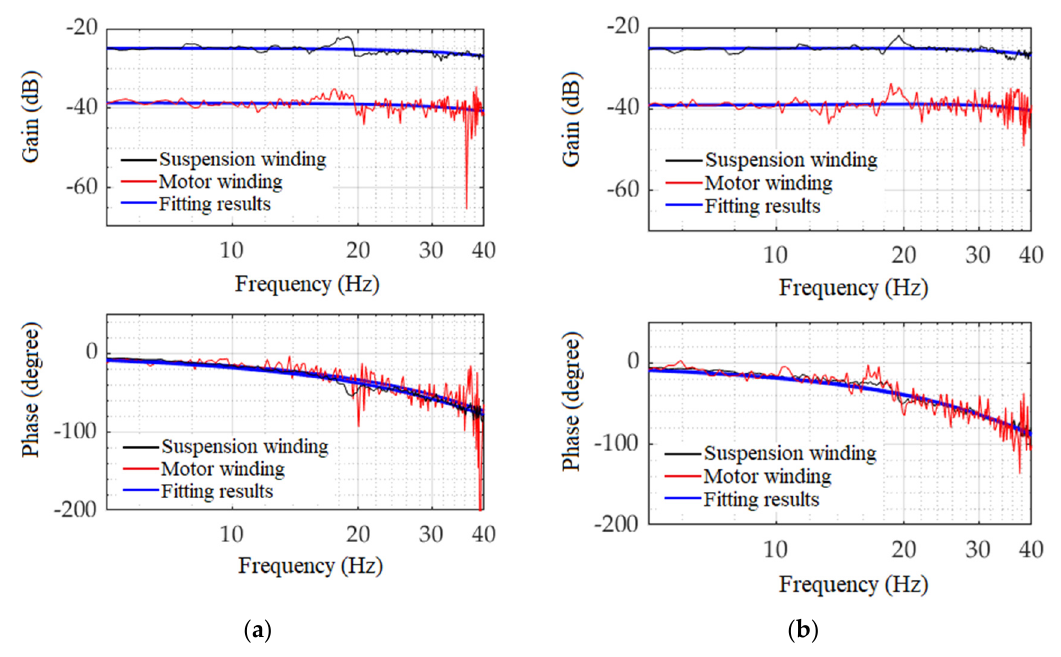
Figure 8. Measured frequency responses of the two bearings in the X -direction using the excitation force generated by the motor windings.